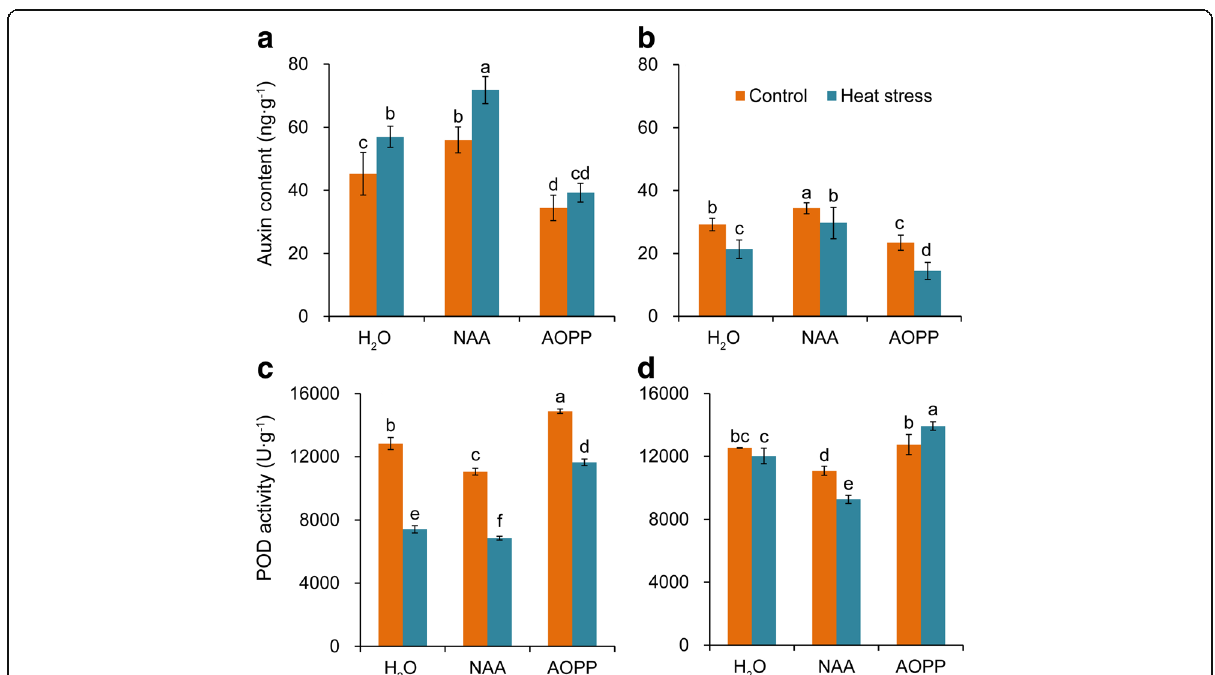
Fig. 2 Changes in auxin levels, and POD activities in the pistil under heat stress. Rice plants were sprayed with either 10 μ mol·L − 1 NAA or 100 μ mol·L − 1 AOPP under natural and heat-stress conditions. a and b show the pistil auxin levels in NPB and HTS, respectively; c and d show the POD activity in the pistil in NPB and HTS, respectively; POD is peroxidase. Vertical bars denote the standard deviation ( n = 3). Different letters indicate significant differences between control and heat stress treatments ( P <